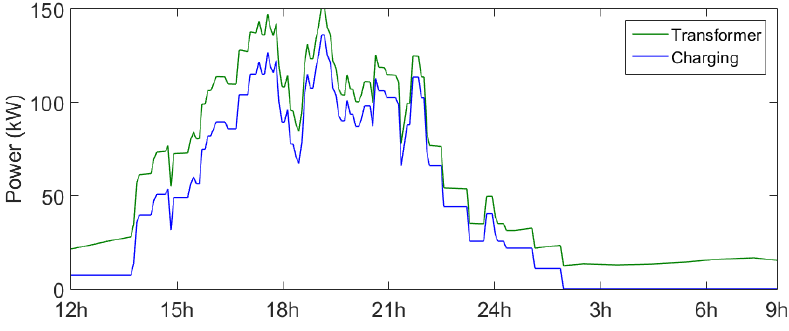
Figure 7. Direct charging power profile.